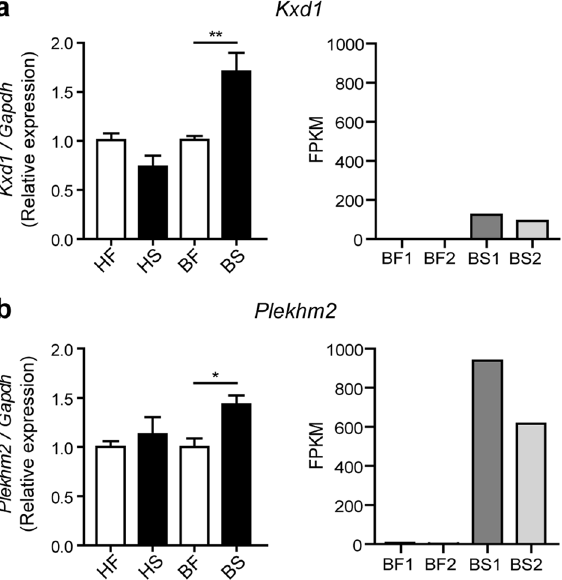
Figure 2. Changes in Kxd1 and Plekhm2 expressions validated by qRT-PCR. ( a ) Left, Raw264.7 macrophages were infected with the M. tuberculosis reference strain H37Rv or BJN followed by autophagy induction by starvation. Kxd1 expression was quantified using qRT-PCR. Relative gene expression was normalised to Gapdh levels using 2 − ∆∆ct method. Data are means ± SEM from at least three independent experiments; **p < 0.01, relative to the full control set of 1.0 was determined by one-way ANOVA with Tukey’s multiple comparison test. Right, FPKM values of Kxd1 transcripts from the RNA-Seq results. ( b ) Left, Plekhm2 expression was quantitated using qRT-PCR as in ( a ). Data are means ± SEM from at least three independent experiments; *p < 0.05, relative to the full control set of 1.0 was determined by one-way ANOVA with Tukey’s multiple comparison test. Right, FPKM values of Plekhm2 transcripts from RNA-Seq results. HF macrophages infected with H37Rv without autophagy induction, HS macrophages infected with H37Rv followed by autophagy induction by starvation, BF macrophages infected with BJN without autophagy induction, BS macrophages infected with BJN followed by autophagy induction by